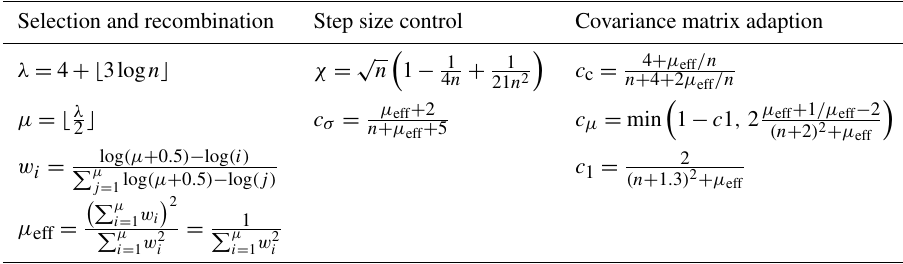
Table 1. Operational constants of the CMA-ES algorithm (cf. the initialization in Algorithm 1). Selection and recombination Step size control Covariance matrix